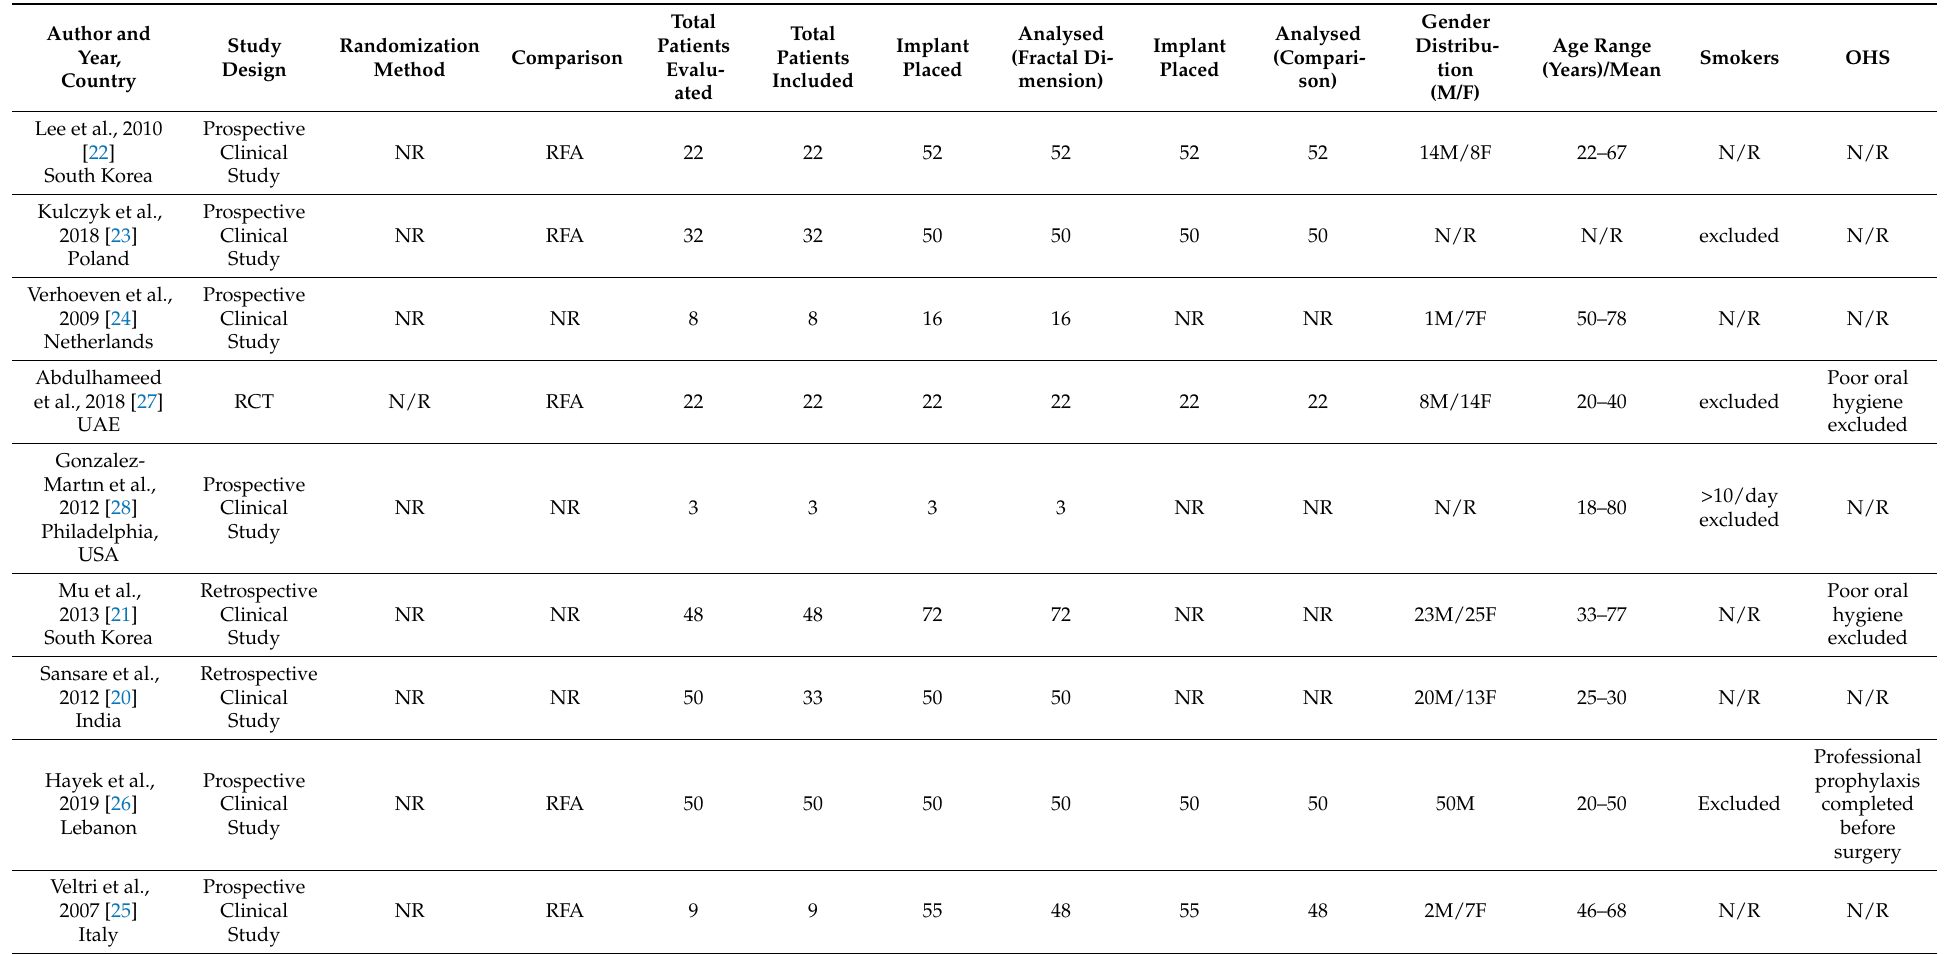
Table 2. Demographic Characteristics of the Included